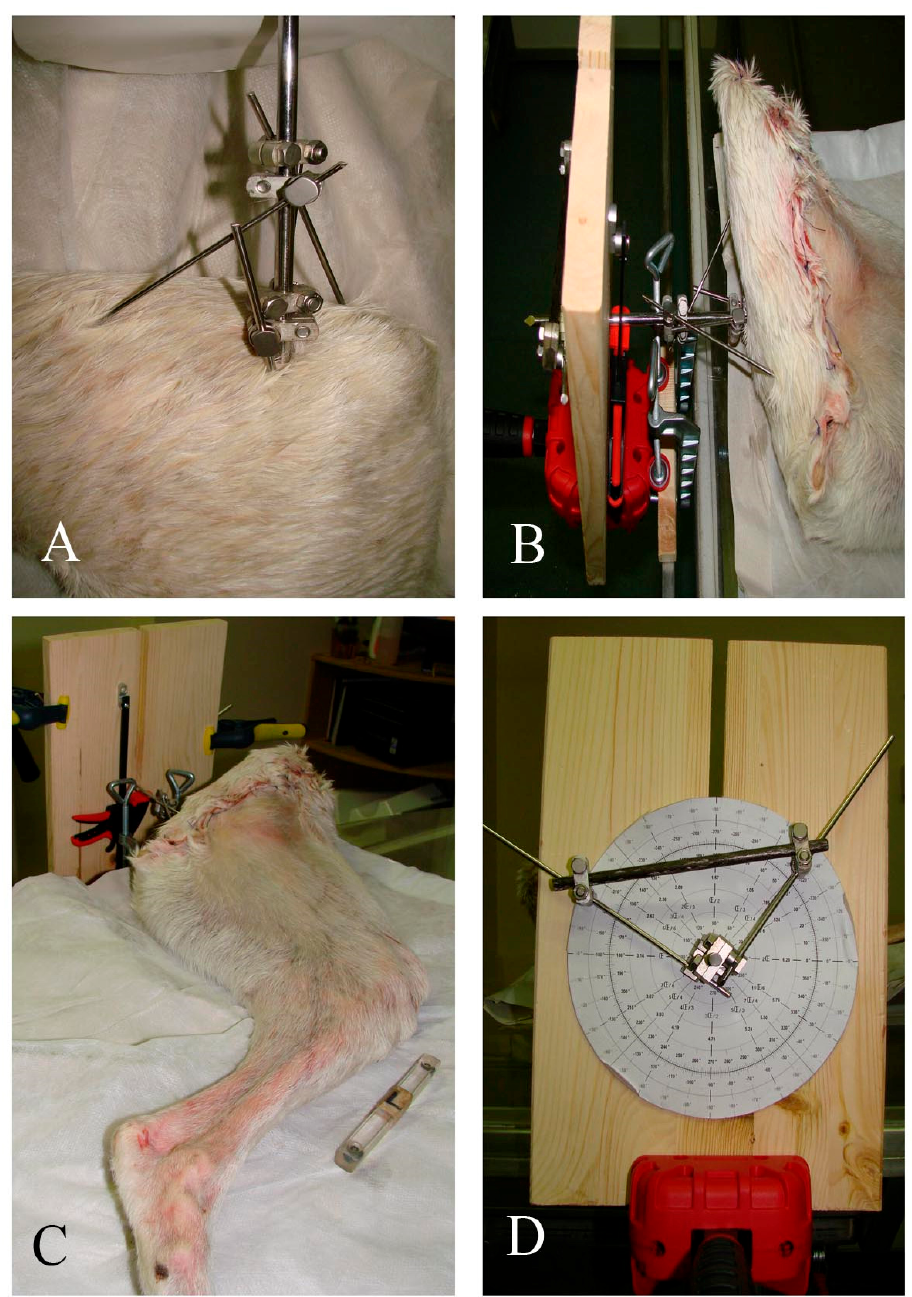
Figure 1. Limb positioning. Pins were used to secure the hemipelvis and to allow manipulation of the femur ( A ). The limb was subsequently connected to a table-mounted device ( B , C ) that allowed precise and controlled manipulation of the limb both in supination/pronation and in abduction/adduction ( D ).